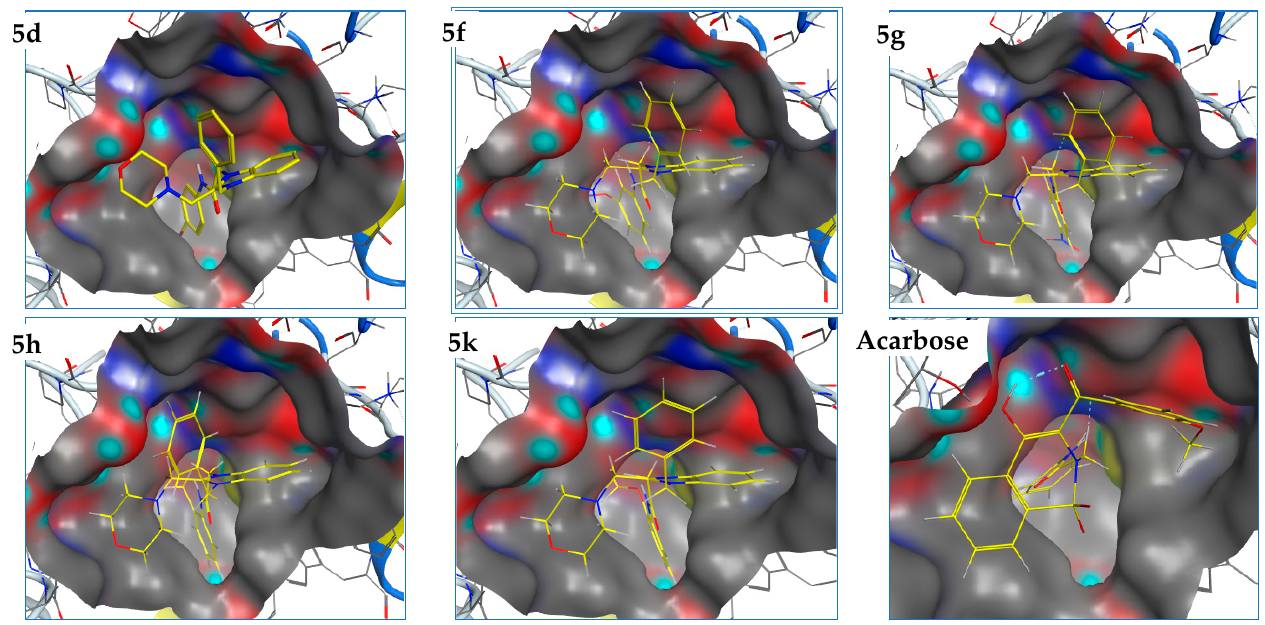
Figure 3. Three-dimensional interaction modes of active compounds ( 5d , 5f , 5g , 5h and 5k ) and standard drug, acarbose. Color portion shows the pocket selected, and red portions indicate the ligand exposure points. Table 1. The in silico screening data of potent N -methylmorpholine-substituted benzimidazolium salts and acarbose.